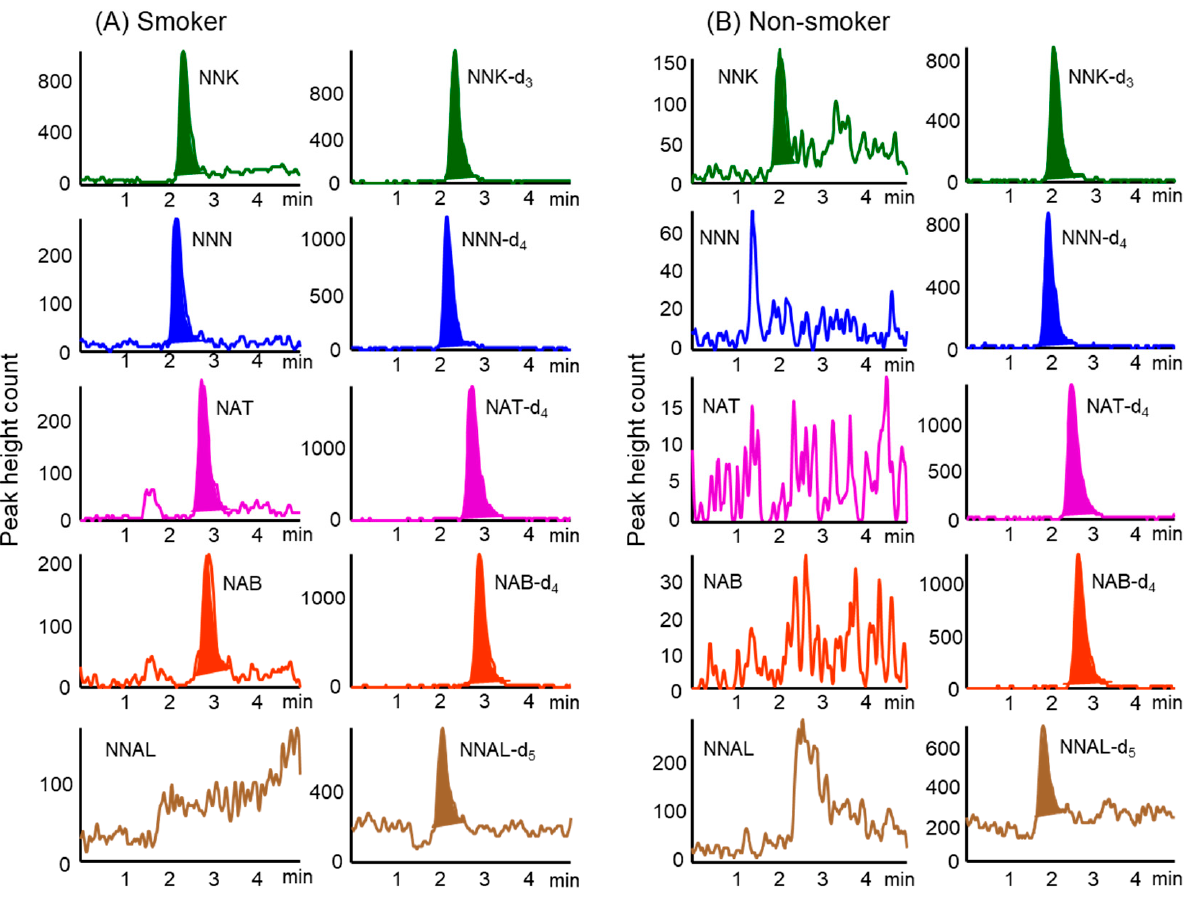
Figure 2. Typical MRM chromatograms were obtained from hair samples of ( A ) smokers and ( B ) non-smoker by in-tube SPME LC–MS/MS. Analytical conditions are described in the Material and Methods section. Table 3. Recoveries of TSNAs spiked into hair samples of a non-smoker.